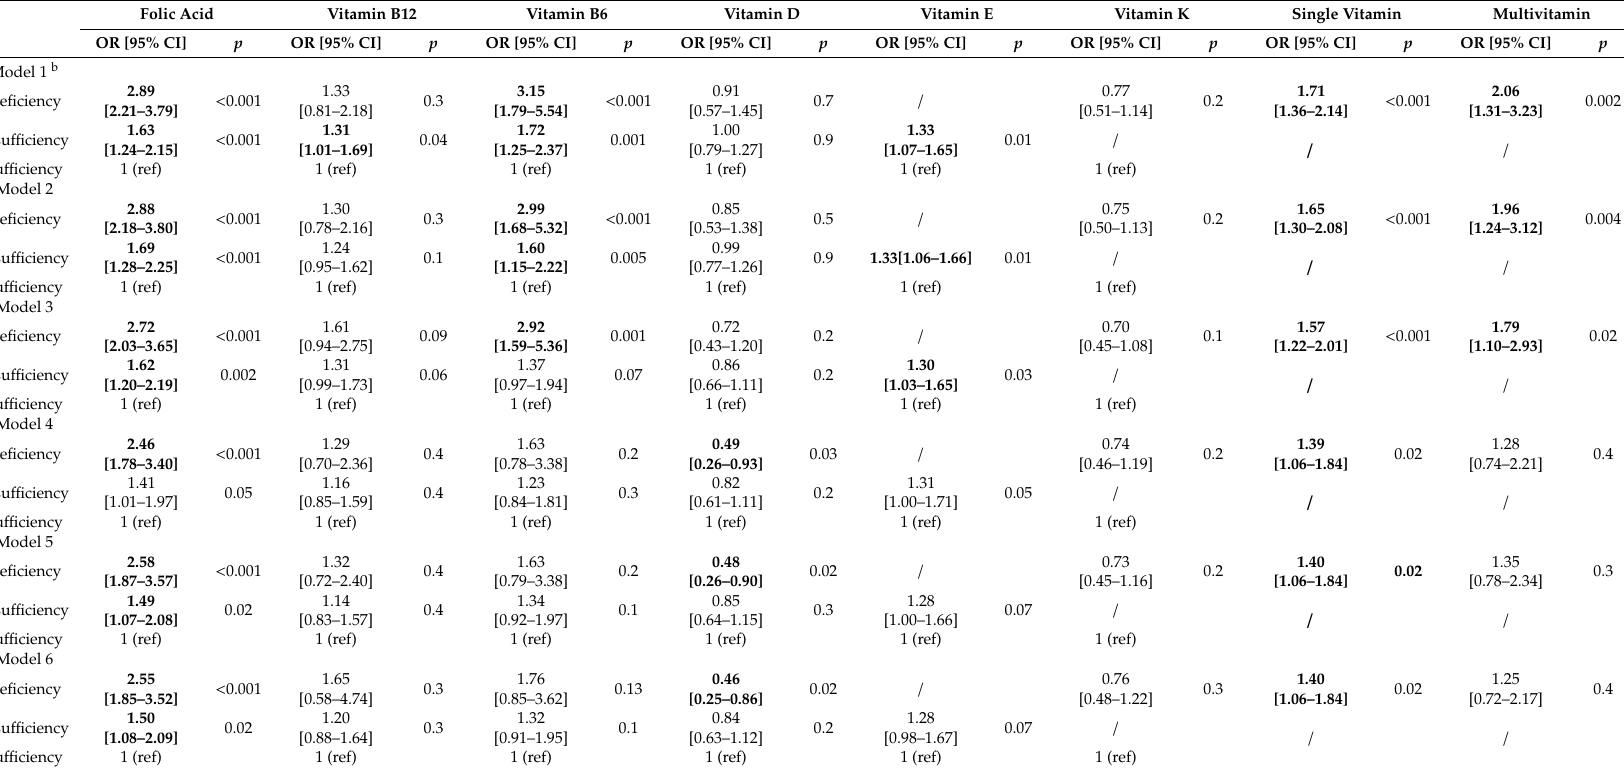
Table 3. Associations between socioeconomic status (SES) and vitamin deficiencies and insu ffi ciencies * (High SES = reference) a